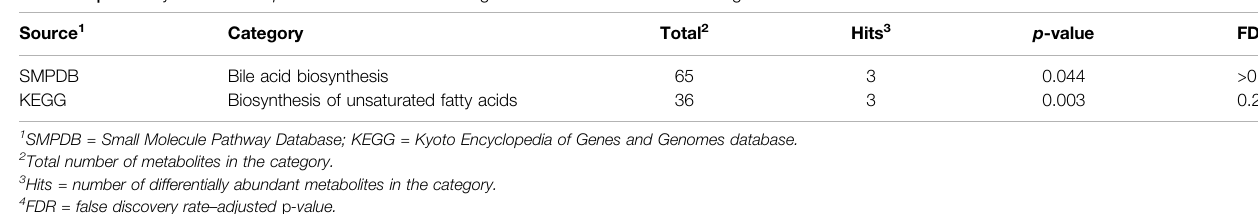
Frontiers in Molecular Biosciences |